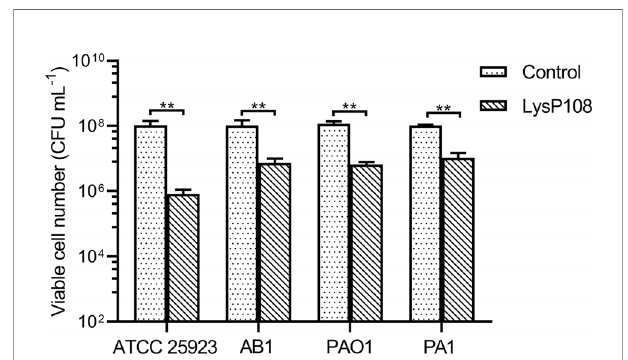
FIGURE 4 | The antibacterial activity of endolysin LysP108 toward S. aureus , P. aeruginosa , and A. baumannii . (n=3). ** P < 0.01.